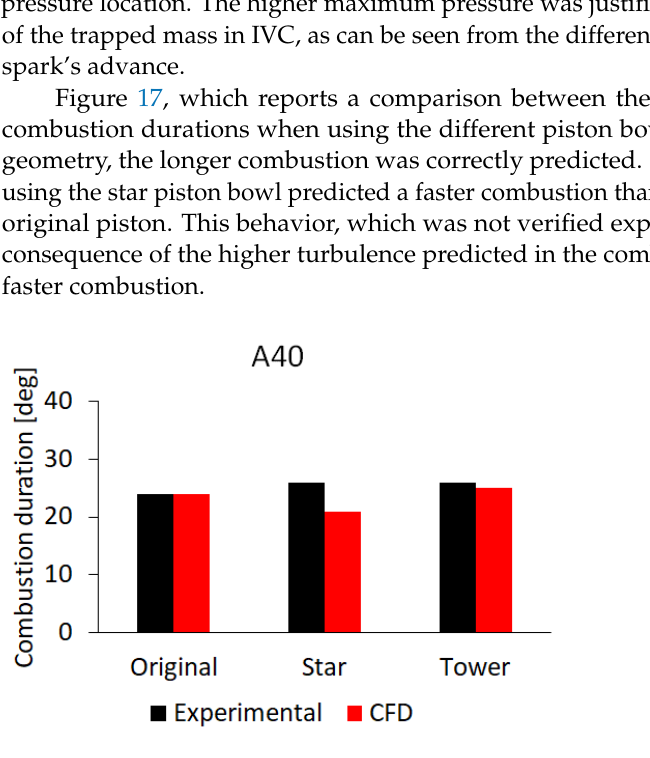
Figure 17. Comparison between the computed and experimental combustion durations for the A40 operating point and the three different piston